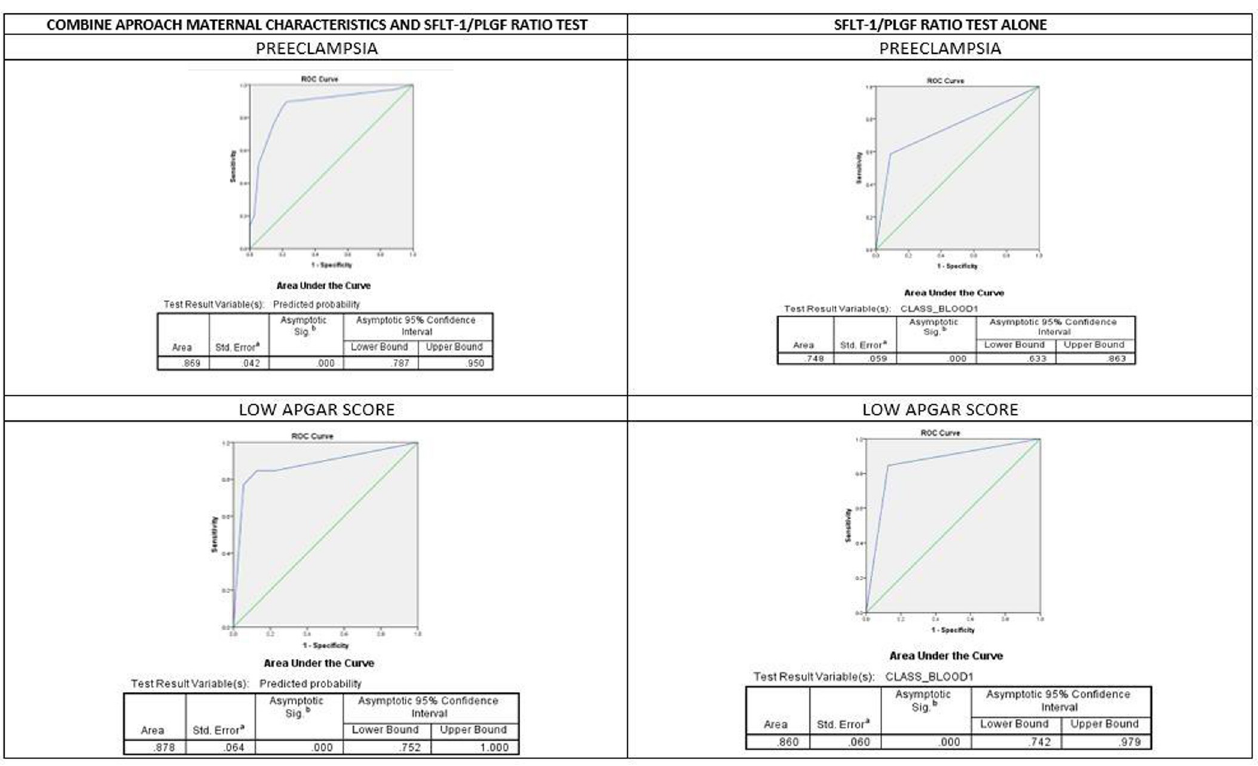
Fig 3. ROC curve comparison between combine maternal and biomarker approach and biomarker